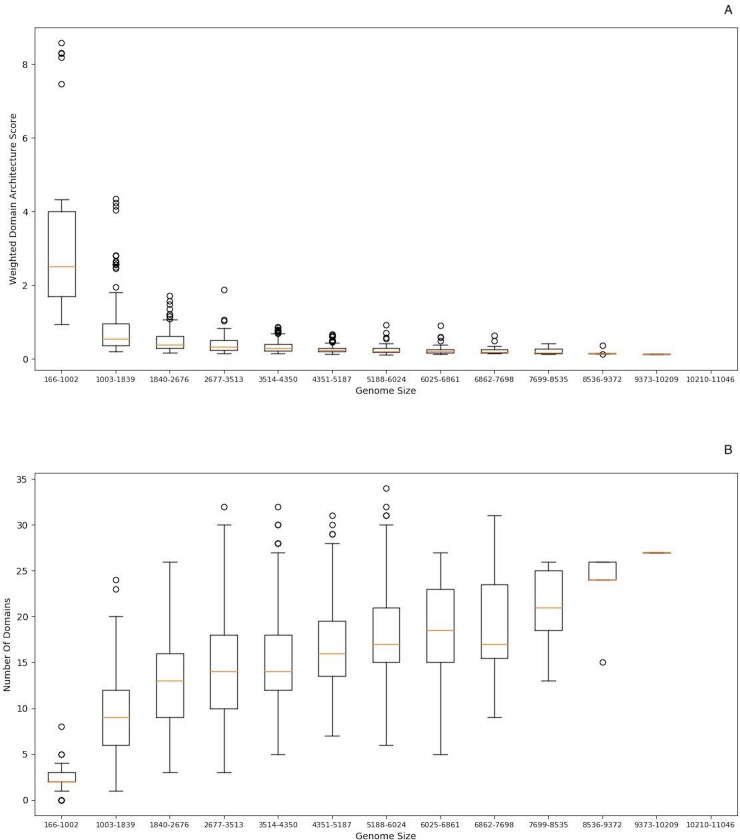
Architecture of the wHTH superfamily as a function of genome size.A) WDAS of the wHTH superfamily (R-value = -0.42; p-value = 2.22E-52); B) number of different domains associated with the wHTH (R-value = 0.545 and p-value = 3.07e-102). On the X-axes of each graph are genome size ranges, displayed in 13 windows, each with a length of 836 ORFs. On the Y-axes are the WDASs. The horizontal lines in the boxes are the median values. The whisker caps represent the minimum and maximum values.